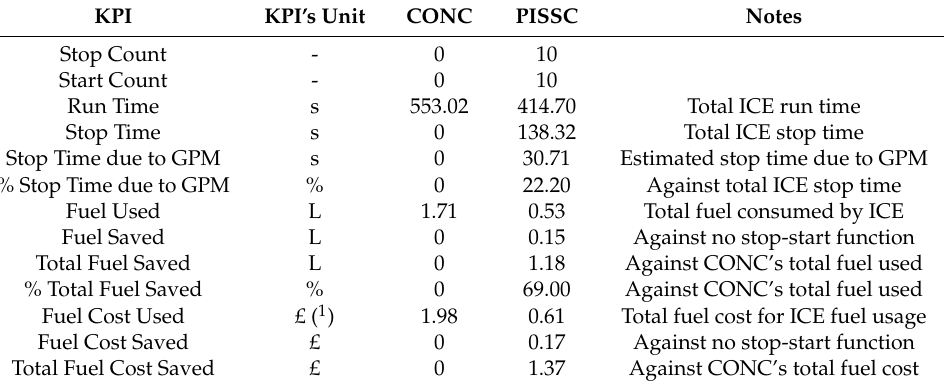
Table 7. KPI analysis for the simulated ICE performances during the last 05 working cycles.